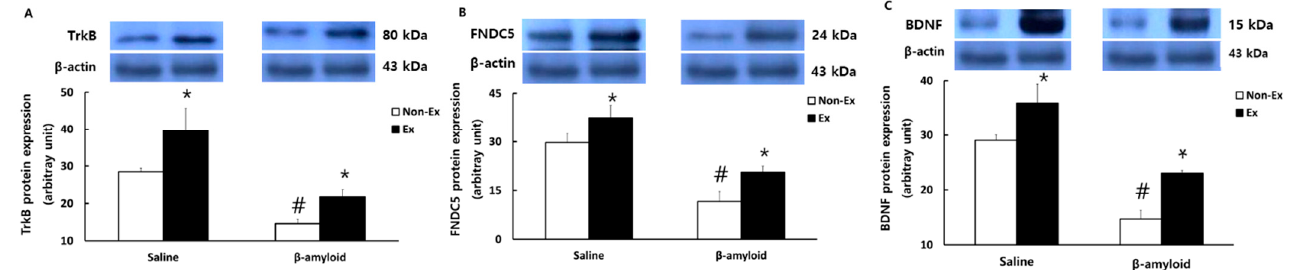
Figure 8. Comparisons of protein expressions of ( A ) TrkB, ( B ) FNDC5, and ( C ) BDNF in the hippocampus after the 12-week intervention. (* p < 0.05 Significant difference as compared to Non-Ex group; # p < 0.05 Significant difference as compared to Saline group).